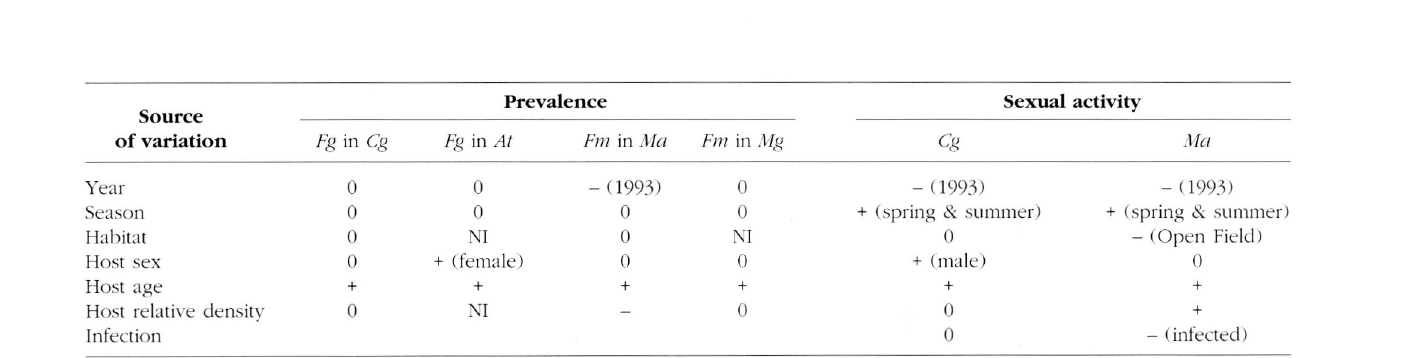
Table VI. - Summarized effects variables on the prevalence of Frenkelia infection and on sexual activity. 0 = not significant, + positive, - negative. Information between brackets indicates which level is source of variation for nominal factors. Fg = Frenkelia glareoli. Fin = Frenkelia